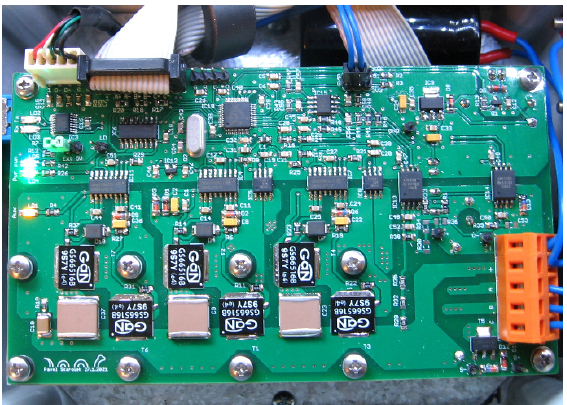
Figure 15. Detail of the inverter board.